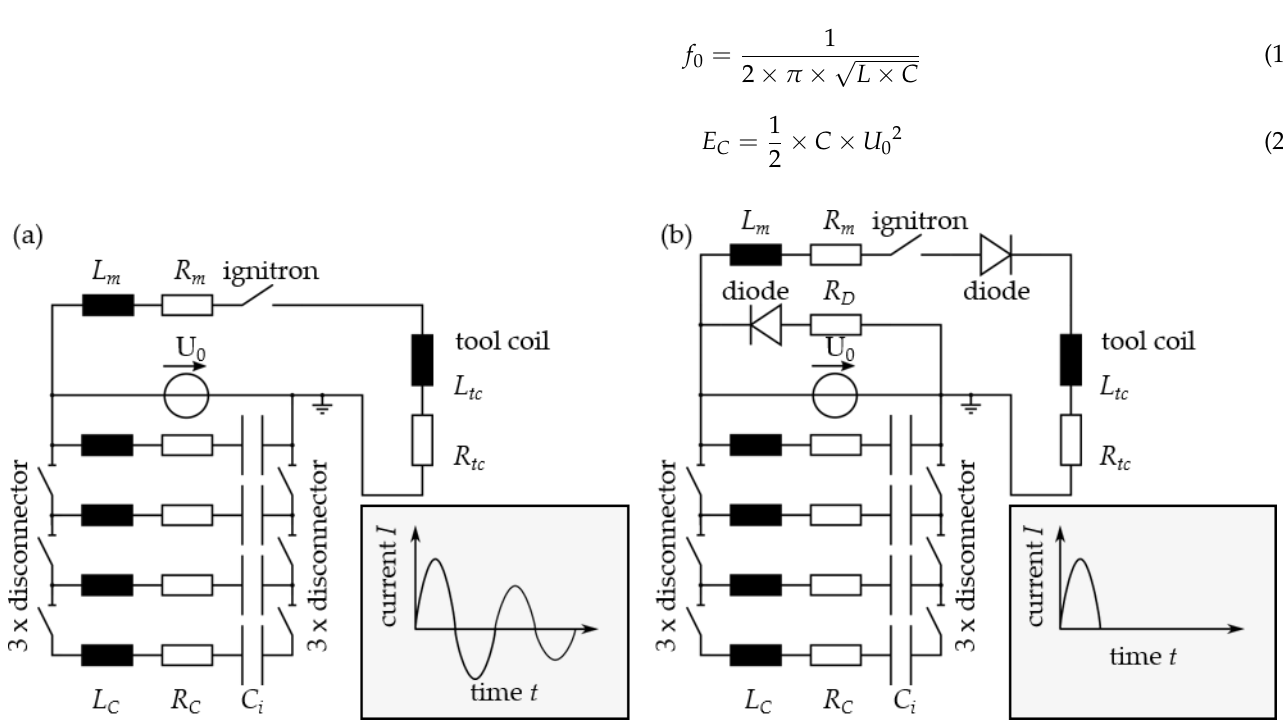
Figure 2. Pulsed power generator: ( a ) oscillator configuration, ( b ) crowbar configuration.